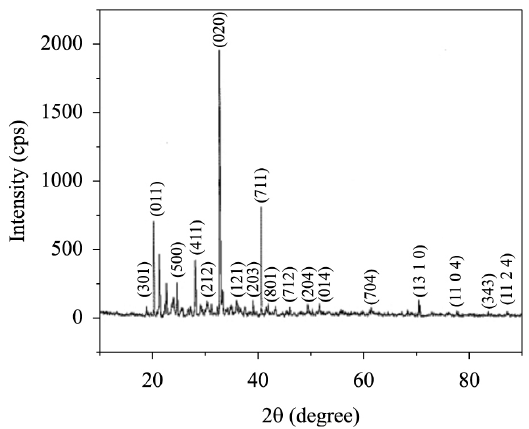
Figure 3. Powder XRD pattern of LCHB